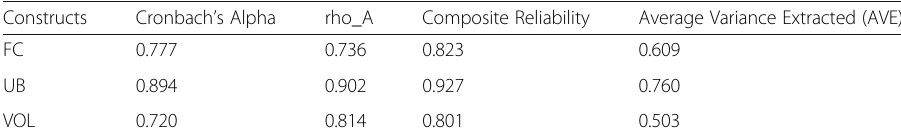
Table 2 Constructs validity and reliability Constructs